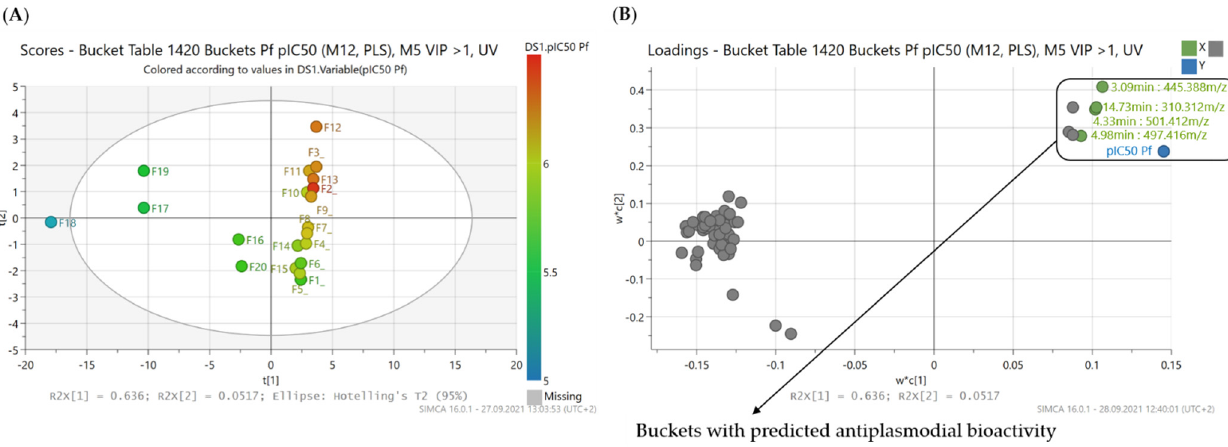
Figure 1. PLS model with prediction of antiplasmodial compounds from B . sempervirens L. ( A ) Scores plot of the second vs. the first PLS component of the PLS model. Coloration indicates the bioactivity against Pf of the fractions ranging from a pIC 50 value of 5.15 (F18, blue) to a value of 6.46 (F2, red); ( B ) corresponding loadings plot to ( A ). The buckets marked with a box in the upper right quadrant are predicted as compounds with high antiplasmodial activity by the PLS model (Buckets marked and labelled in green are detailed in Figure 2).